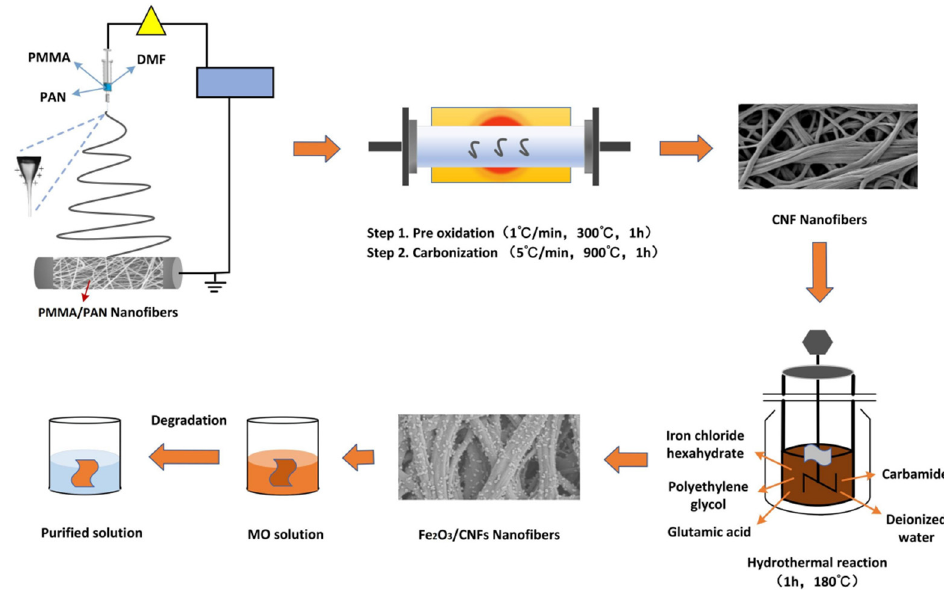
Figure 1. Schematic illustration of fabrication of Fe 2 O 3 /CNFs composite nanocatalysts and their degradation of MO.